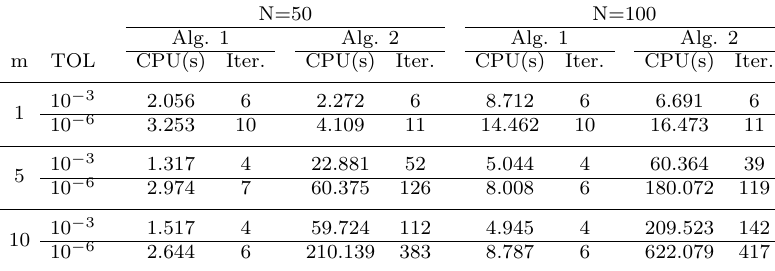
Table 3. Experiment for Algorithms 1 and 2 with a same data N=50 N=100 Alg. 1 Alg. 2 Alg. 1 Alg. 2 m TOL CPU(s) Iter. CPU(s) Iter. CPU(s) Iter. CPU(s) Iter. 10 − 3 1